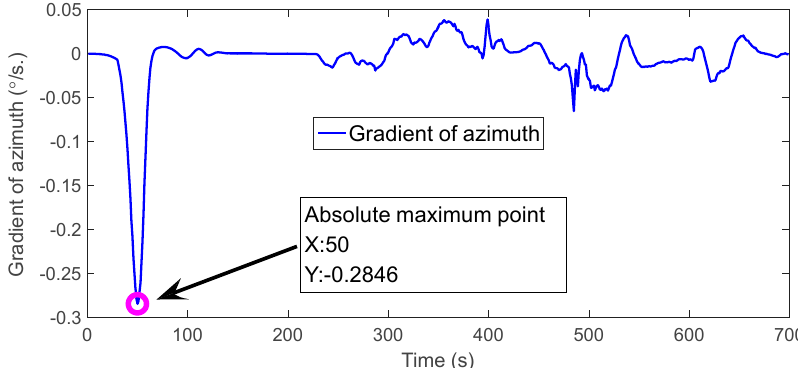
Figure 8. The gradient values of azimuth angle error (dynamic vehicle experiment).